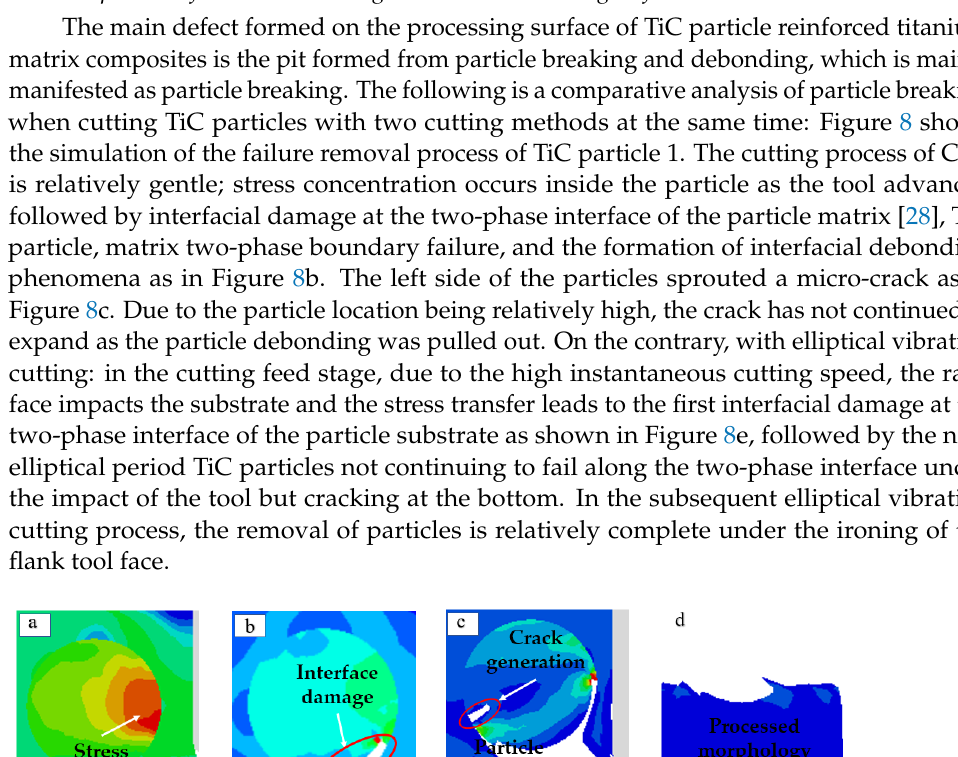
Figure 7. Comparison curve of cutting temperature.